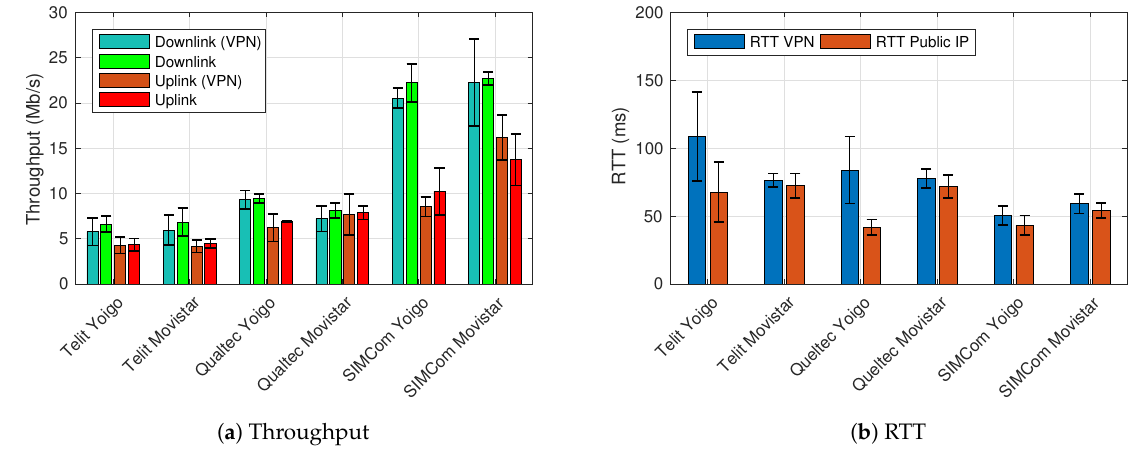
Figure 5. Performance analysis upon the